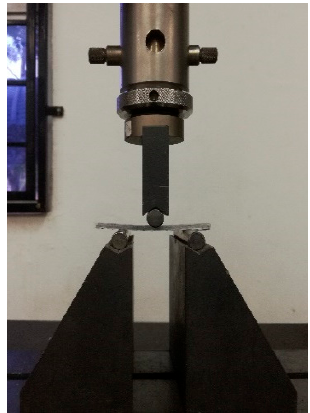
Figure 4. Three-point bending test on the fiber reinforced polymer (FRP) composites .